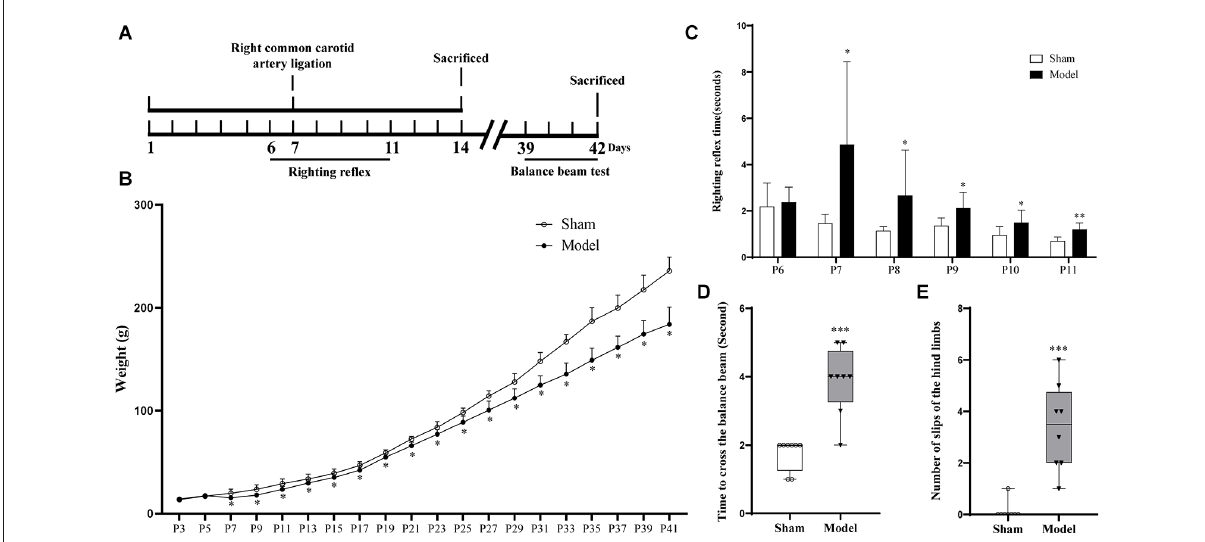
FIGURE1 (A) Flow chart of the HIE animal model experiments. (B) After the operation, the Model group showed continuously significantly less weight than the Sham group ( p < 0.05, n = 10). (C) The Model group showed significantly longer righting reflex time from P7 to P11 than the Sham group ( p < 0.05, n = 8). (D) Compared with the Sham group, the model group showed a longer time to pass the balance beam and (E) higher frequency of leg-slips ( p < 0.001, n = 8). *Denotes statistical significance. ∗ p < 0.05 vs. Sham. ∗∗ p < 0.01 vs. Sham; ∗∗∗ p < 0.001 vs.